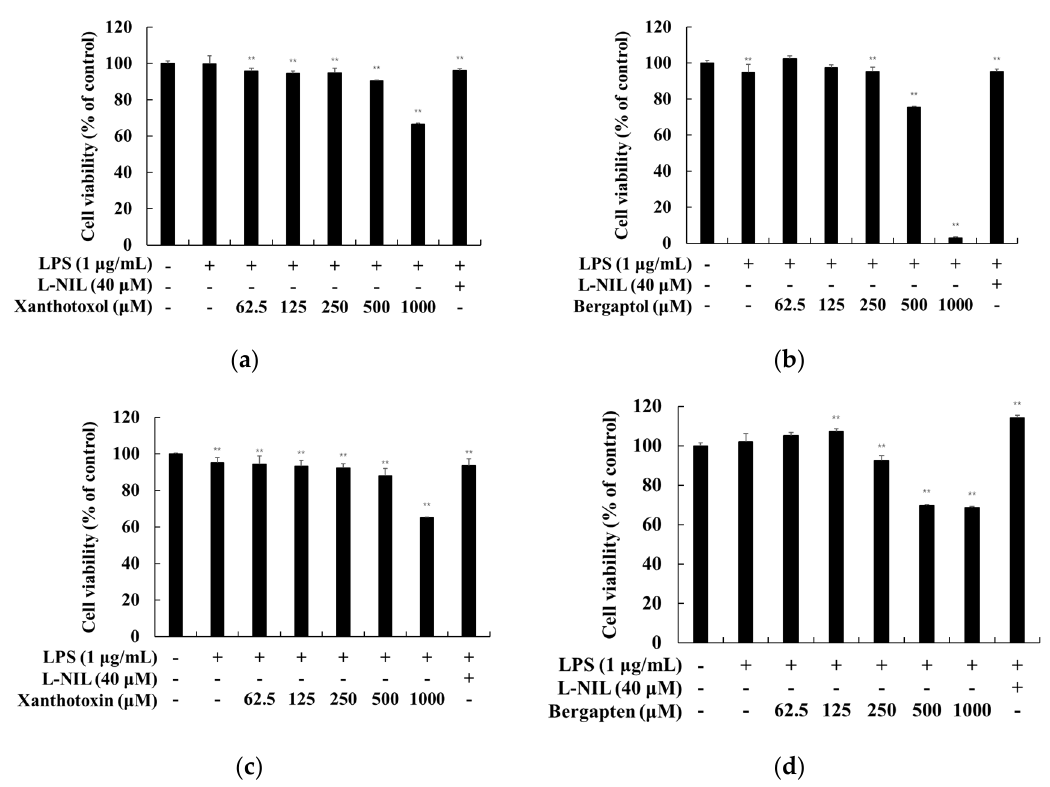
Figure 2. Effect of psoralen derivatives on the cell viability in LPS-induced RAW 264.7 cells. The cells were treated with psoralen derivatives (62.5, 125, 250, 500, and 1000 μ M) and L-NIL (40 μ M) for 24 h with LPS (1 μ g/mL). L-NIL was used as a positive control. The cell viability of LPS-induced RAW 264.7 cells subjected to ( a ) 8-hydroxypsoralen (xanthotoxol), ( b ) 5-hydroxypsoralen (bergaptol), ( c ) 8-methoxypsoralen (xanthotoxin), and ( d ) 5-methoxypsoralen (bergapten) were measured using an MTT assay. The results are presented as the mean ± SD from three independent experiments. ** p < 0.01 vs. untreated control group.